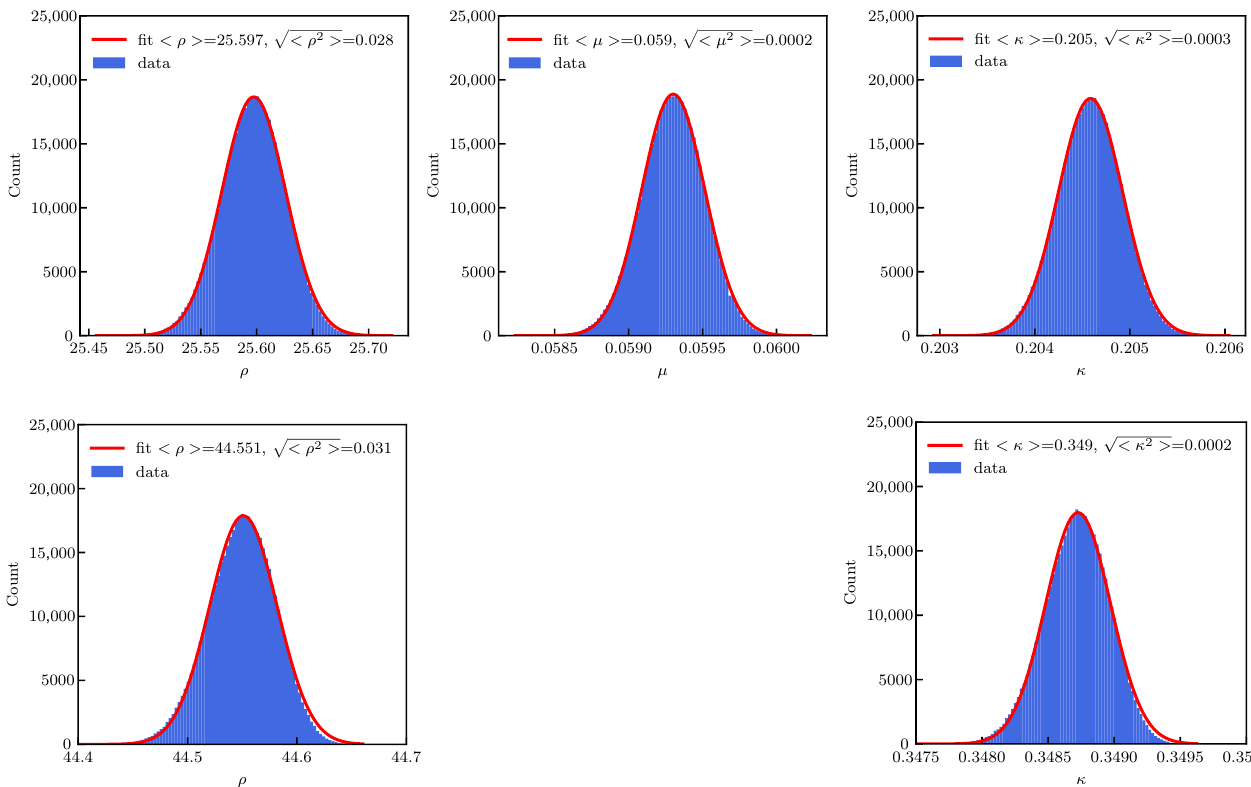
Figure 10. ( Top row ): Distribution of the parameters for the fit of the DA model (14b) with three parameters, after applying a GP 5 × 10 5 times to the DA numerical data. ( Bottom row ): Same, but for the model with two parameters. Fits of a Gaussian functions are also shown for